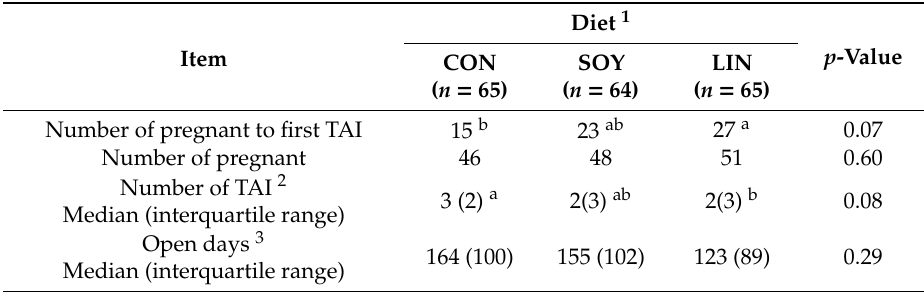
Table 5. Fertility response of